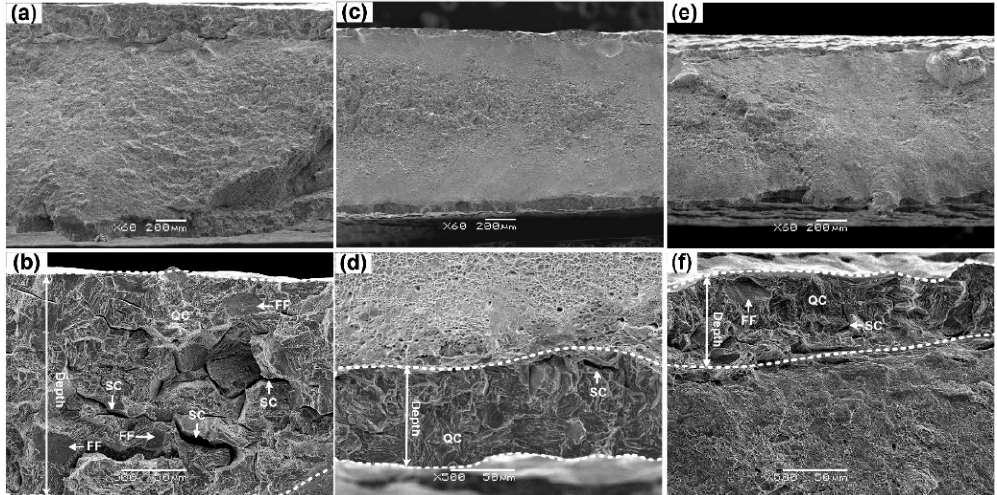
Figure 9. SEM surfaces of 304L specimens. ( a , b ) Prestrained to 30% at 20 °C; ( c , d ) prestrained to 30% at 50 °C; ( e , f ) prestrained to 30% at 80 °C.